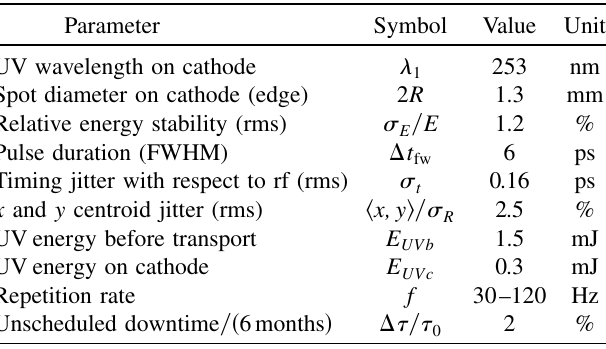
TABLE II. Typical drive laser parameters.